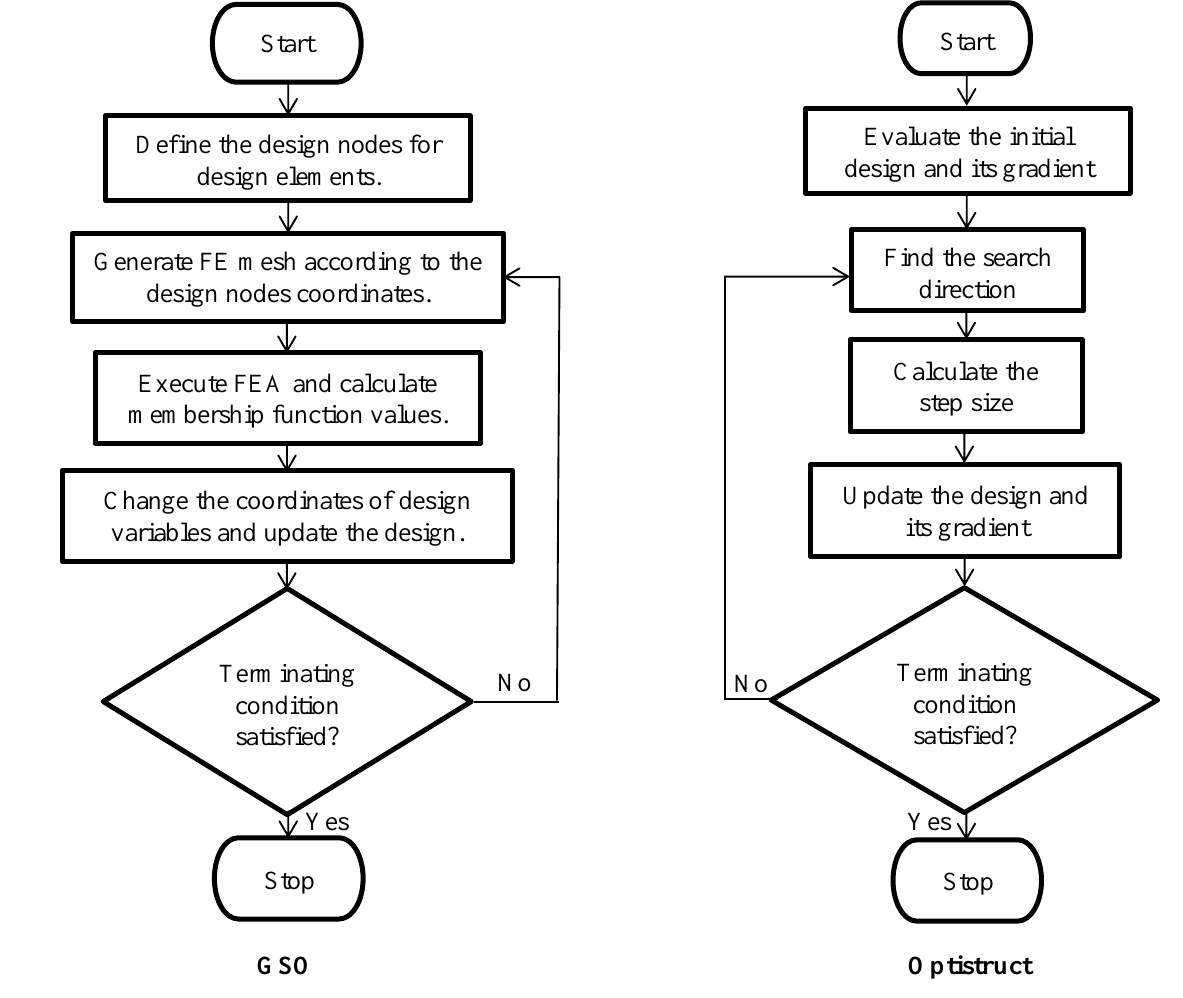
Figure 6. Flowchart for working steps in GSO and